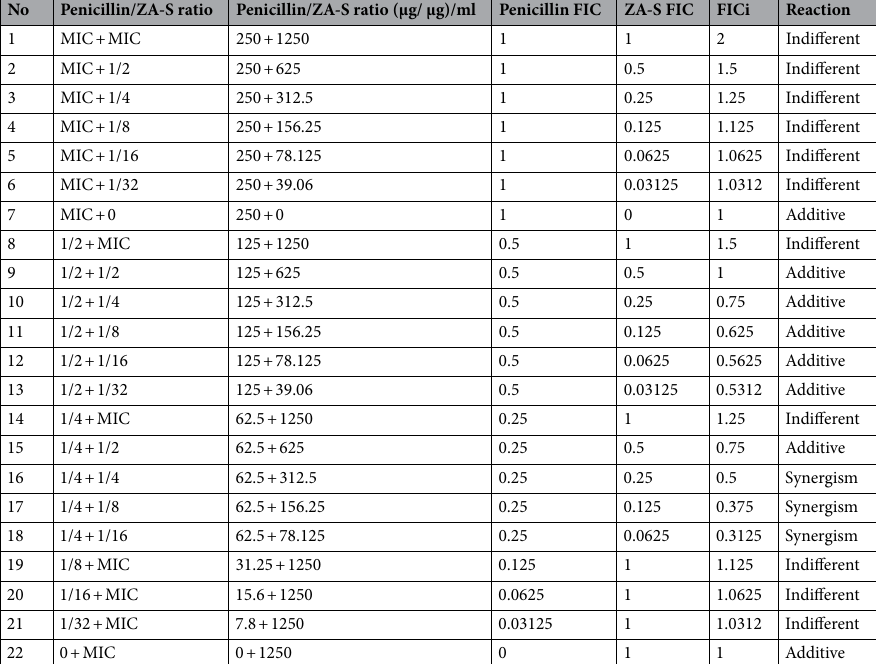
Table 6. Checkerboard results of penicillin and ZA-S combinations against MRSA M-4.